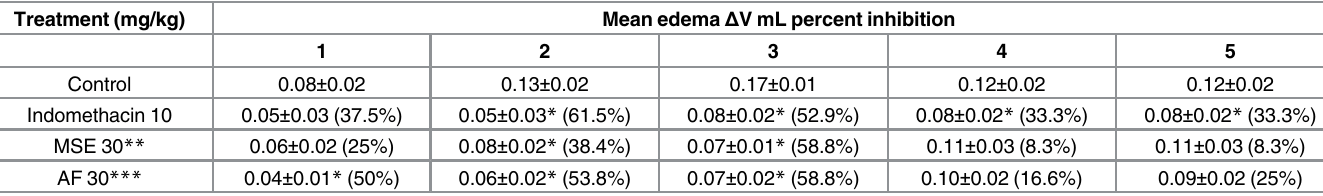
Table 2. Effect of MSE and the AF on carrageenan-induced paw edema on mice. Treatment (mg/kg)